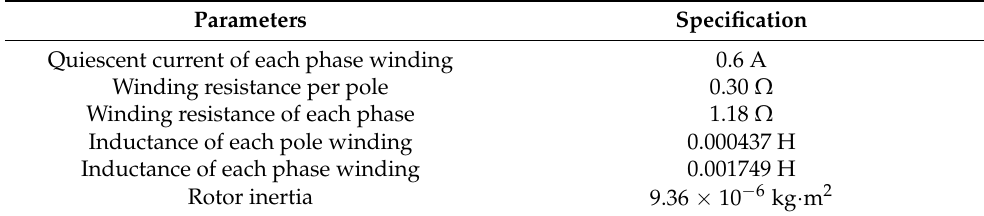
Table 2. Dual- redundancy HSM specifications.